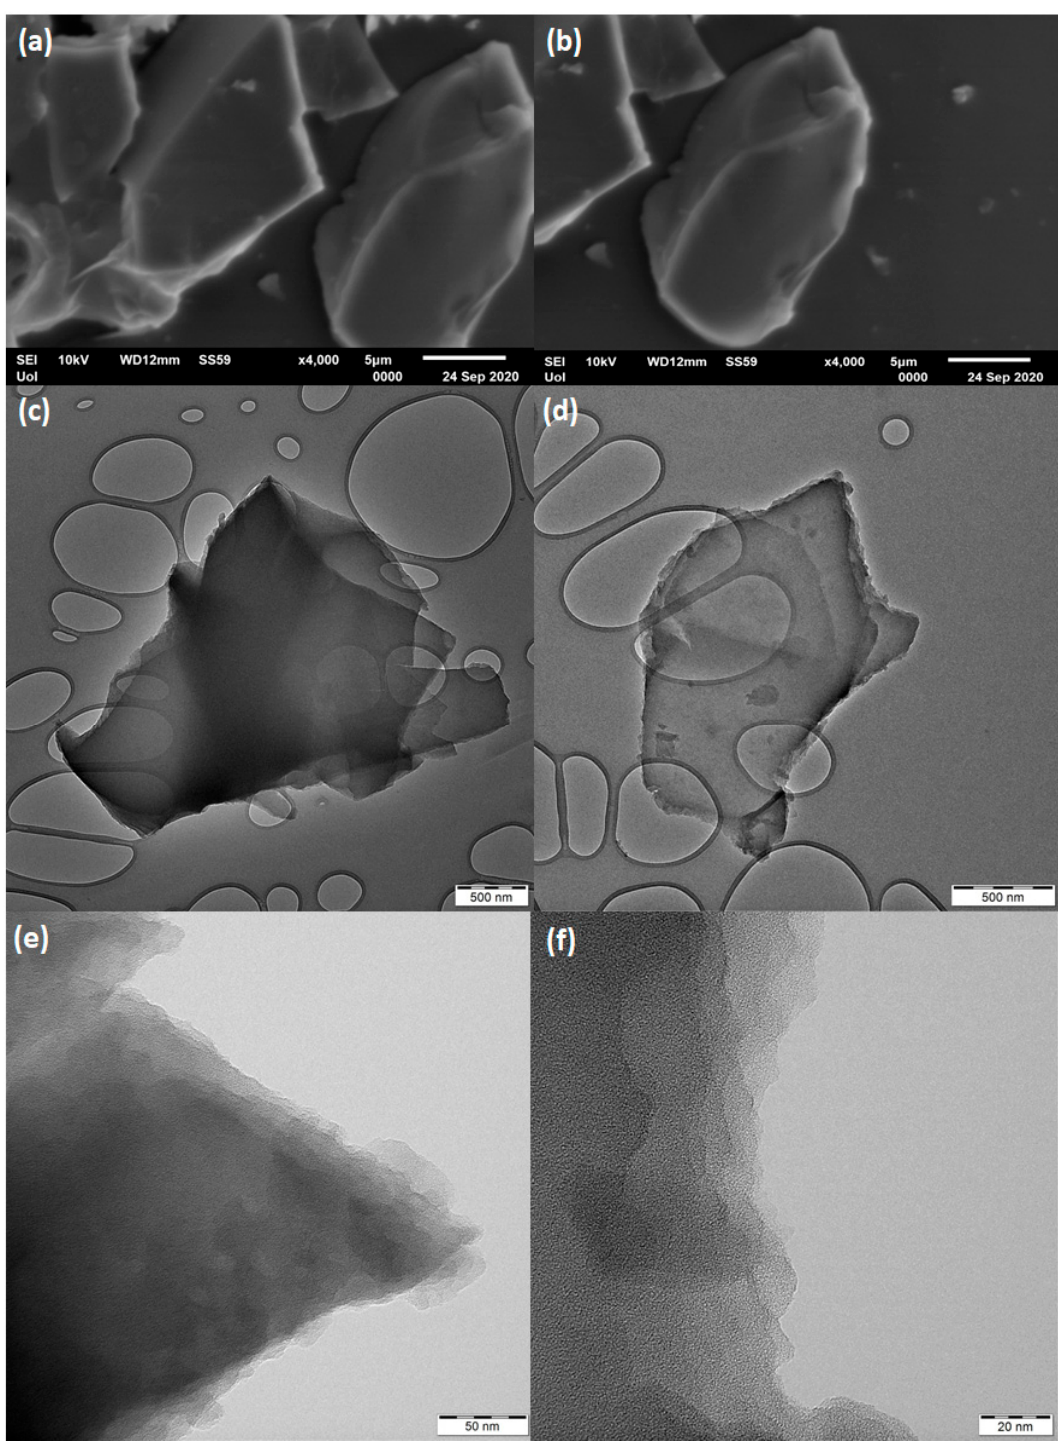
Figure 7. Scanning electron microscopy (SEM) ( a , b ) and transmission electron microscopy (TEM) ( c – f ) images of carbon nanosheets.